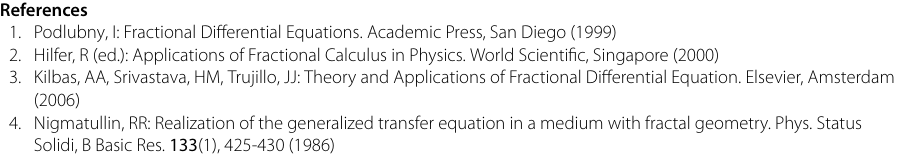
Table 3 The numerical convergence orders in temporal direction with h = 1